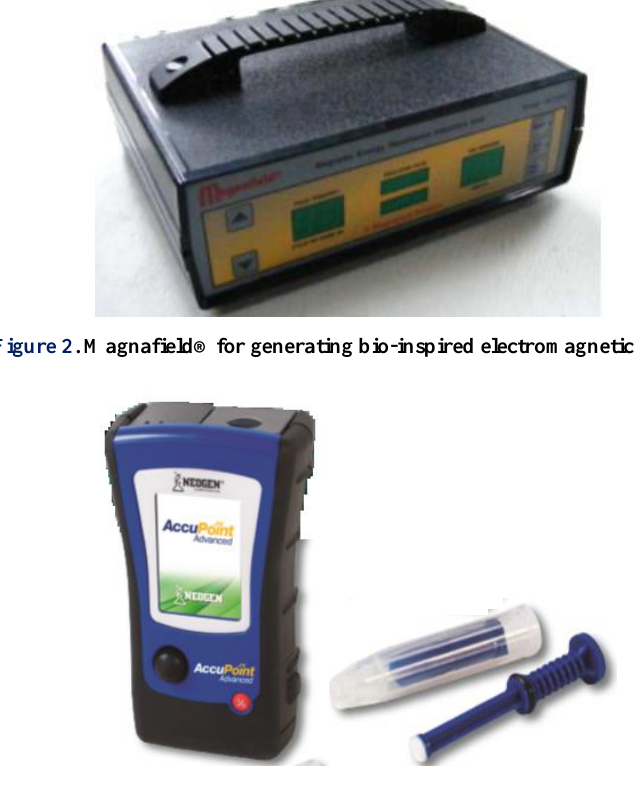
Figure 3. Neogen's The AccuPoint Advanced ATP Hygiene Monitoring System and AccuPoint Advanced Surface Samplers for measuring ATP.